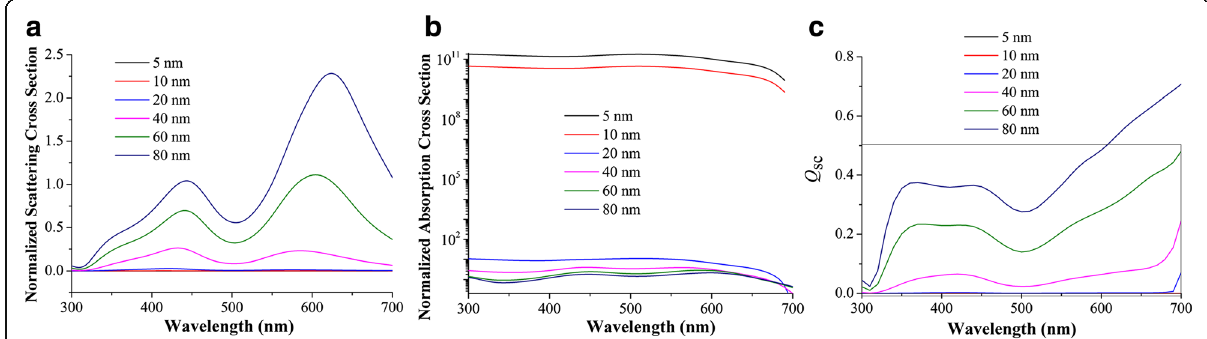
Fig. 5 Normalized scattering cross section ( a ), absorption cross section ( b ), and scattering efficiency ( c ) of different-sized NPs in the homogeneous active